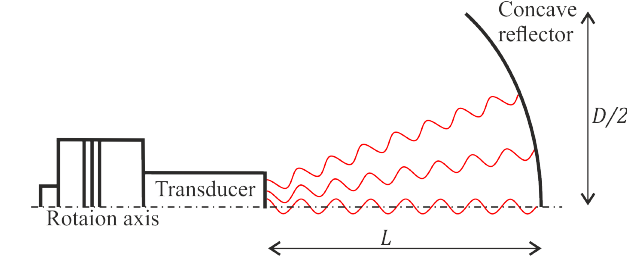
Figure 5. Wave propagation directions at a standing wave system with concave